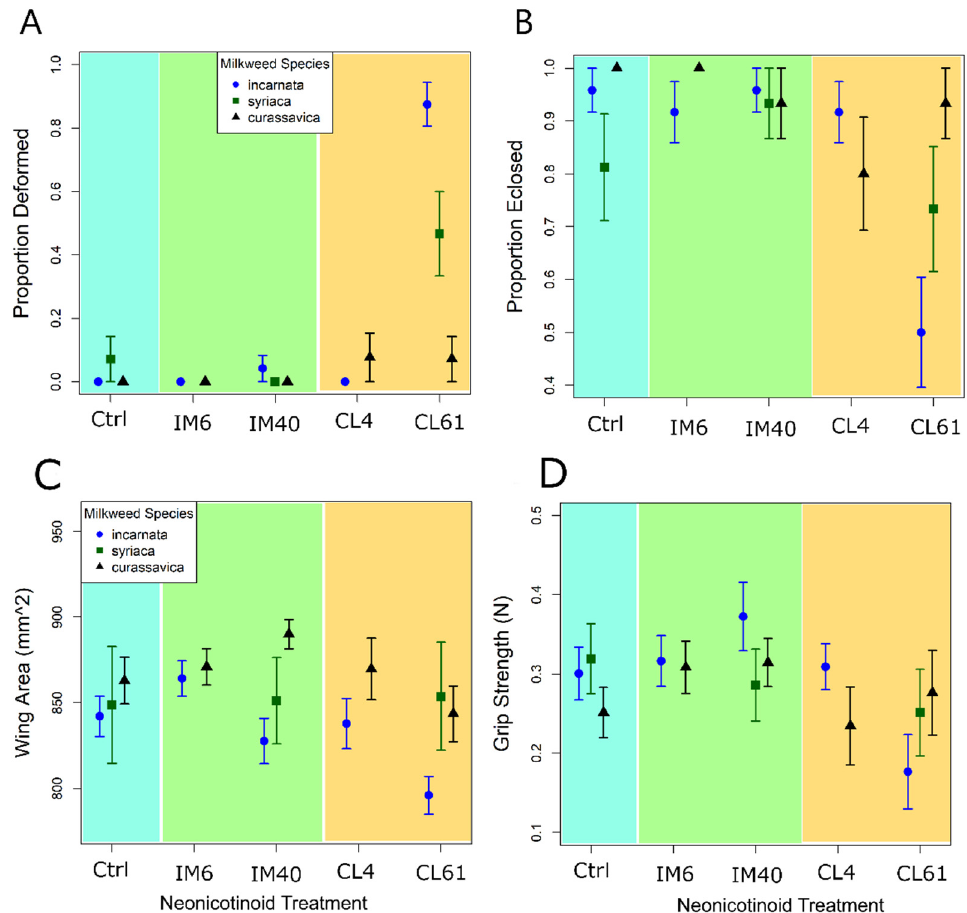
Figure 2. Experiment 2. Effects of detected dose of neonicotinoids and milkweed species on monarch deformity, eclosion, grip strength, and wing area. Numbers under the neonicotinoid treatment indicate the realized dose (ng/g) on leaf tissues. IM = Imidacloprid, CL = Clothianidin. Swamp milkweed ( A. incarnata ) is in blue circles, tropical ( A. curassavica ) is in black triangles, and common milkweed ( A. syriaca ) is in green squares. ( A ) The proportion of monarchs that showed deformed pupae; ( B ) The proportion of monarchs that eclosed successfully; ( C ) Forewing area (mm 2 ) of monarchs; ( D ) Grip strength (newtons) as measured by monarchs’ ability to pull a rod.